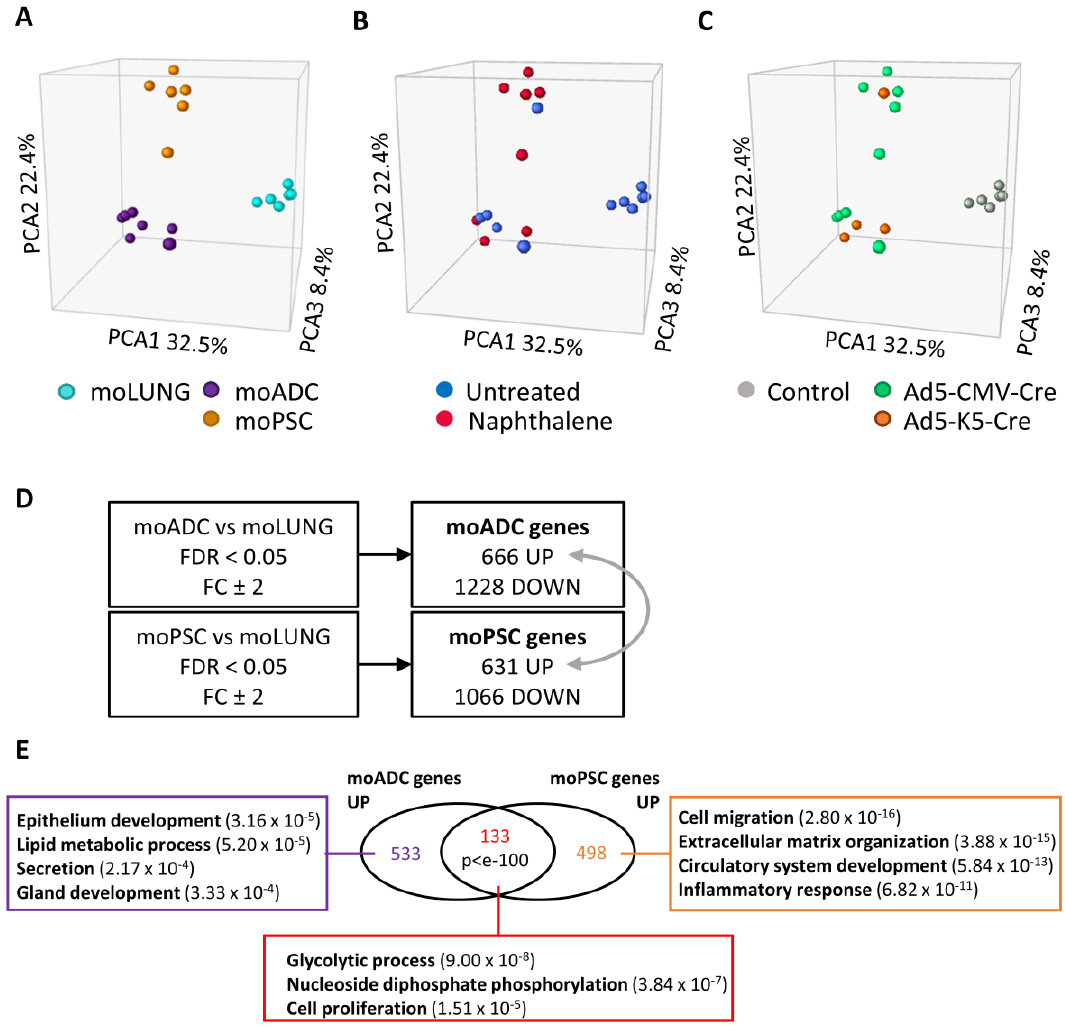
Figure 5. Gene expression analysis of lung ADC and PSC arising from DKO mice. Principal component analysis (PCA) plots showing the distribution of the samples along the PC1, PC2 and PC3 axes and labeled according to: ( A ) their histology type (moLUNG, pale blue color; moADC, purple; moPSC, orange); ( B ) untreated (blue) or naphthalene treated (red) samples; ( C ) the adenoviral vector used (control uninfected, grey; Ad5-CMVcre, green; Ad5-K5cre, orange). ( D ) Genes significantly (FDR < 0.05) upregulated or downregulated more than two-fold in moADC or in moPSC compared to moLUNG. Numbers indicate Affymetrix probe set identifiers. FDR, false discovery rate; FC, fold change. ( E ) Gene ontology analysis of moADC and moPSC upregulated genes (grey arrow in ( D )). The Venn diagram shows genes common to both tumor types (133) or specific of moADC (533) or moPSC (498). Hypergeometric test was used to assess the statistical significance of the overlap ( p < 10 − 100 ). The rectangular boxes contain the main signaling pathways enriched in the indicated groups (gene ontology biological processes). p -values in